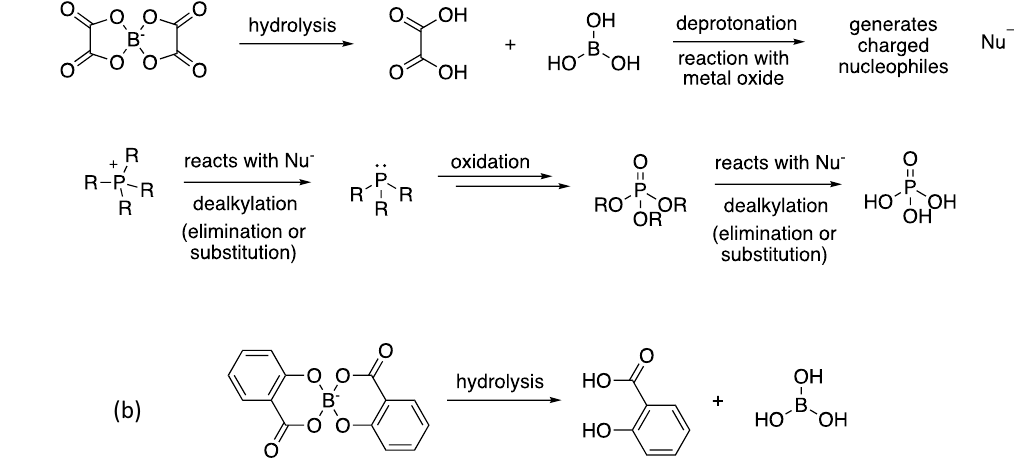
Scheme 1. (a) Stepwise breakdown of PBOB (for full mechanistic analysis, see Supporting Information). Breakdown of the anion generates the nucleophiles (shown as Nu − ) required for subsequent breakdown of